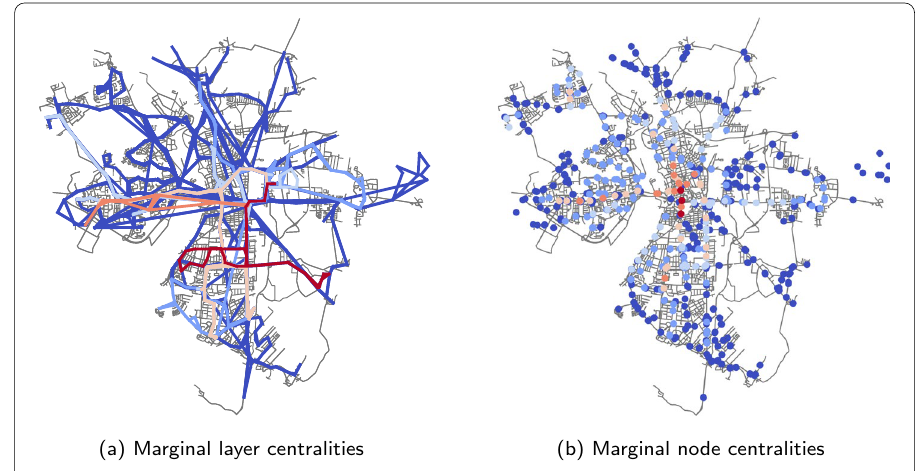
Fig. 7 Example of marginal layer and marginal node subgraph centralities of Halle (Saale). Central lines and stops are marked red and non-central lines and stops are marked blue. The entries in the supra-adjacency matrix are weighted with travel times and frequencies. The parameters are chosen β = 0.5 / (cid:31) max , σ = 5 , and (cid:31) t transfer = 5 . The street network in the background of the plots is created with the OSMnx python package (Boeing 2017). Left: Marginal layer centralities (corresponding to a ranking of the lines). Right: Marginal node centralities (corresponding to a ranking of the